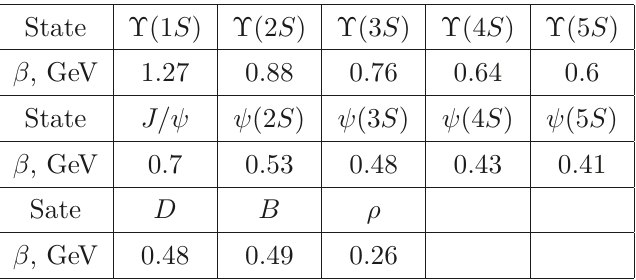
Table 6 . The Gaussian parameters β of different